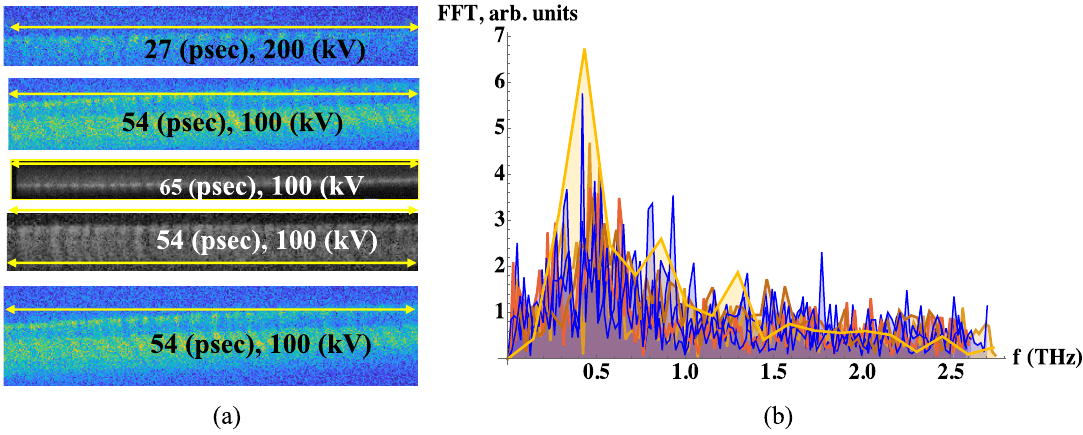
FIG. 16. (a) A subset of five YAG4 profile images showing distinct patterns of the density modulation driven by PCI in 0.7 nC (peak current of 1.75 A) electron bunches. (b) Twelve overlapped spectra of images taken for 0.7 nC bunches. The noise floor above 1.5 THz is determined by noise of the digital camera used for the imaging. The yellow curve shows a spectrum of density modulation extracted from the SPACE PCI simulations, where it has a maximum at about 0.45 THz and secondary peaks at double and triple of this frequency as a sign of the PCI